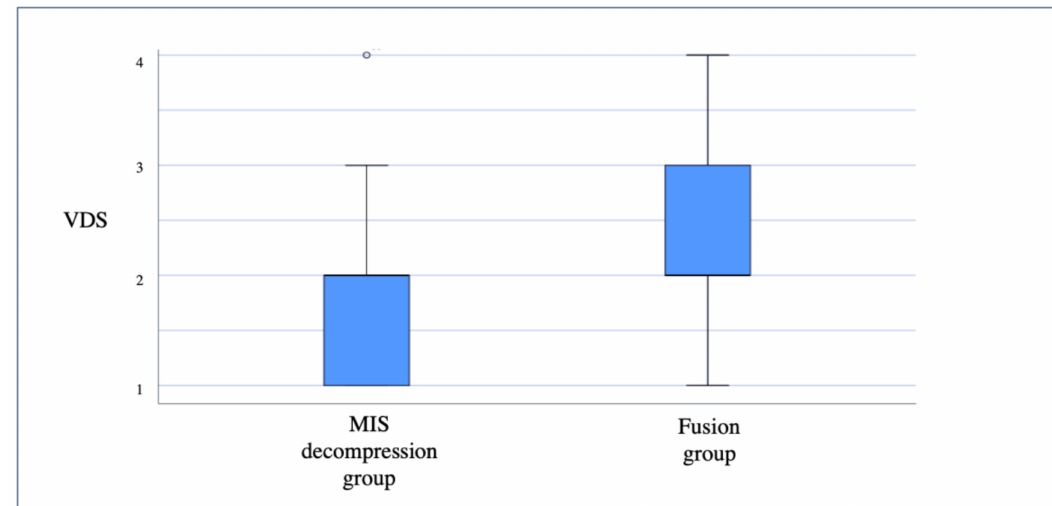
Figure 1. Distribution of the reported Verbal Descriptor Scales (VDS) for back pain for the MIS decompression and fusion groups.